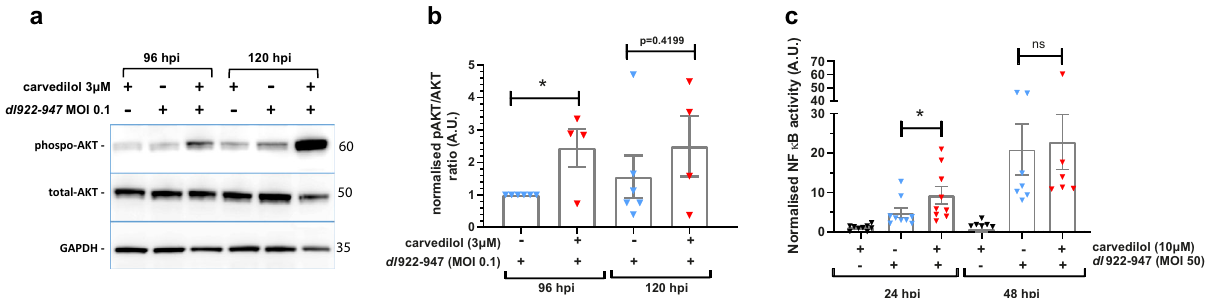
Fig. 4 Carvedilol and dl 922-947 in fl uence signalling downstream of β -arrestins. a Representative western blots of pAkt/Akt in Ov4Carbo cells. b ) Densitometry ratios of phospho-Akt total Akt in Ov4Carbo cells following infection with dl 922-947 (MOI 0.1; n = 6 biological repeats) and±carvedilol (3 μ M; n = 4 biological repeats) 96 and 120hpi (mean±SEM, unpaired t- test, ns P >0.05, * P ≤ 0.05) c ) NF κ B promoter activity in Ov4Carbo cells following infection